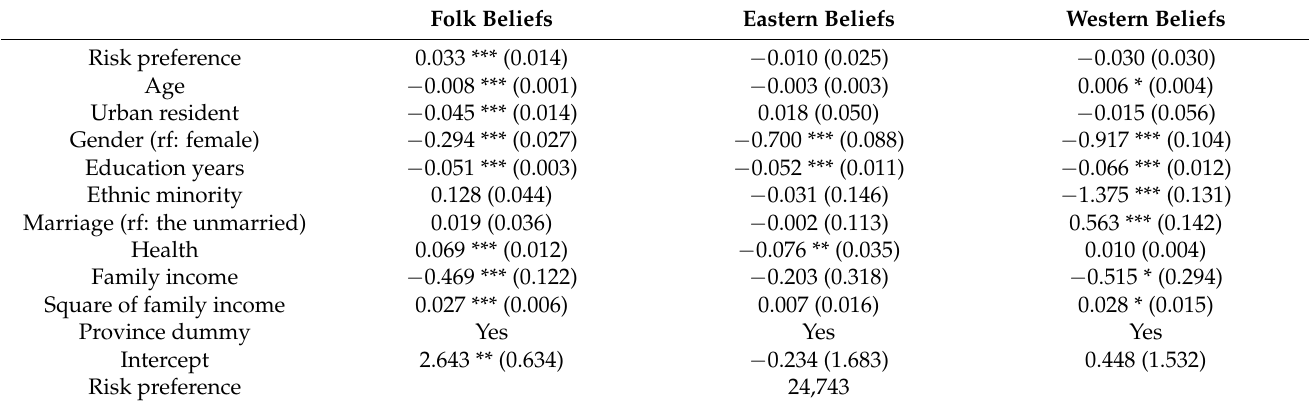
Table 4. Multinomial logistic regression for effects of risk preference on having a religious belief.